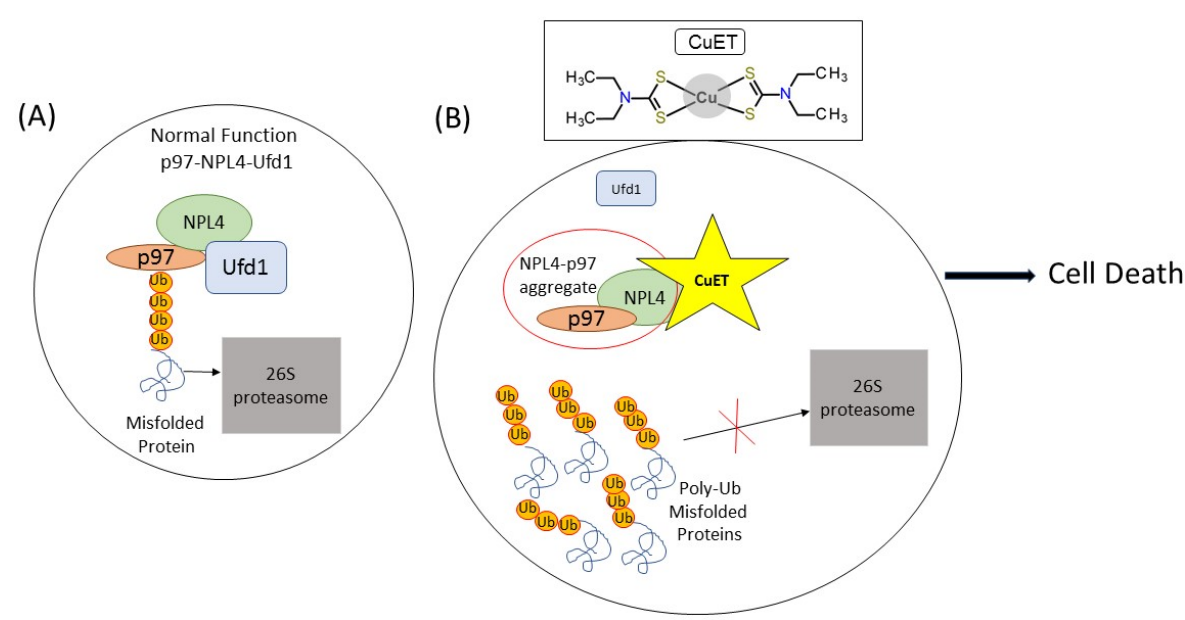
Figure 1. Simplified scheme of the CuET action. ( A ) Under normal condition, NPL4 and Ufd1 cofactors bind p97/VCP segregase. The p97-NPL4-Ufd1 complex allows the processing of ubiquitinated proteins with the 26S proteasome. ( B ) The CuET binds to NPL4 and causes aggregation of p97-NPL4. Therefore, the p97-NPL4-Ufd1 complex is not formed; ubiquitinated proteins accumulate in the cell, leading to cell death.